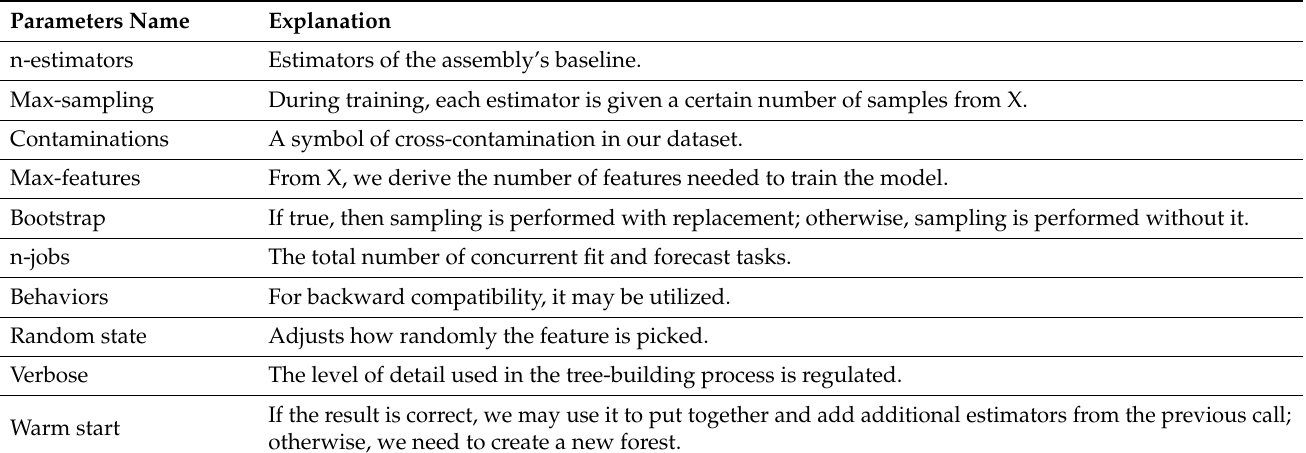
Table 10. The key variables employed in isolation forest.